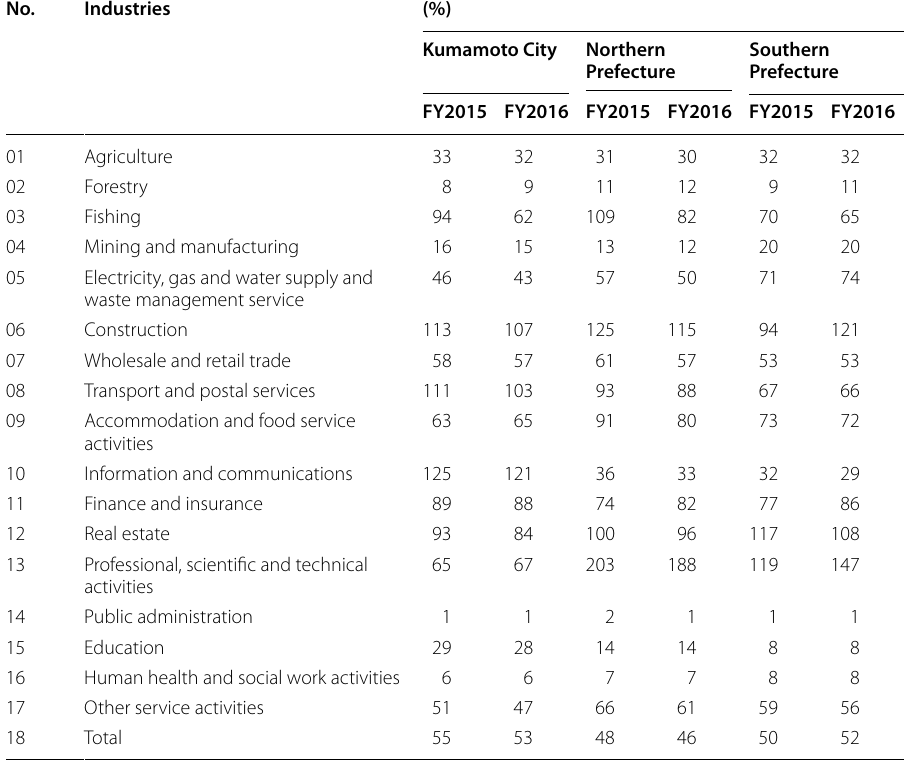
Table 8 Annual cumulative induced value-added coverage to GRDP